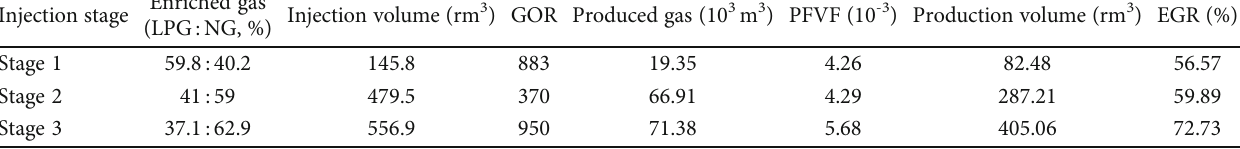
Table 4: Injection and production data of enriched gas fl ooding in the fi eld Z and calculated